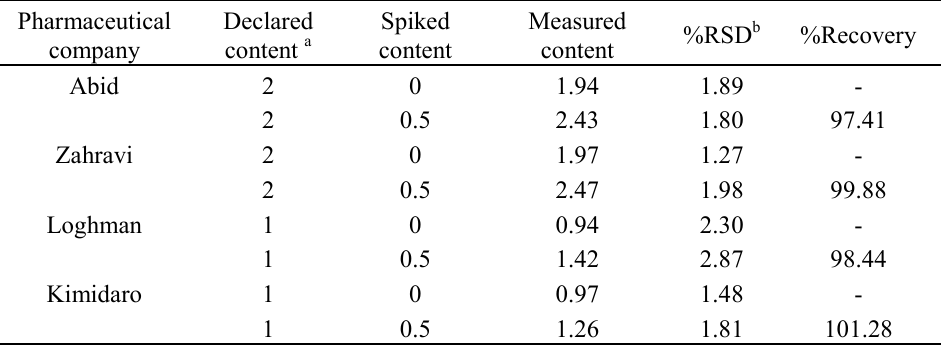
Table 3. Determination of lorazepam in pharmaceutical by FTIR